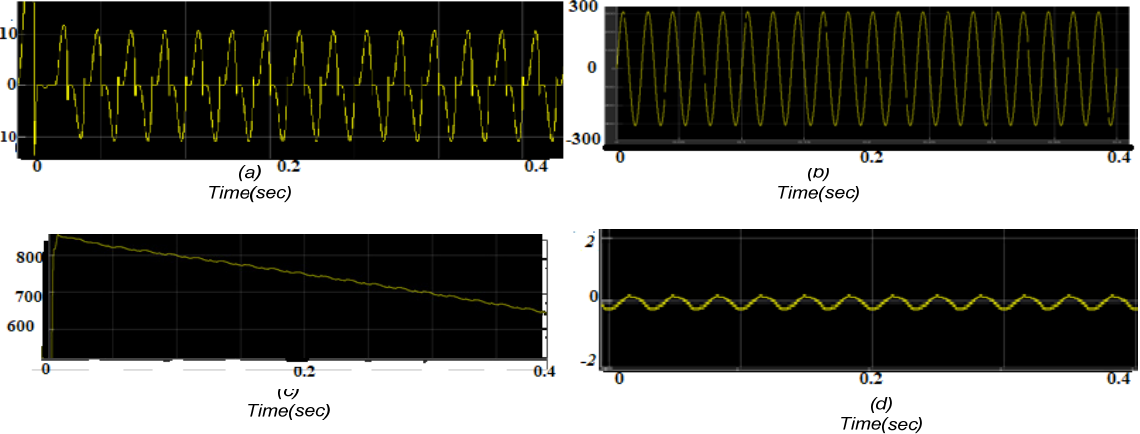
Figure 10. Case 1 GRU-based system signals. ( a ) Source current; ( b ) source voltage; ( c ) DC voltage; ( d ) neutral wire current. Table 5. Comparative analysis of the total harmonic distortion (THD).